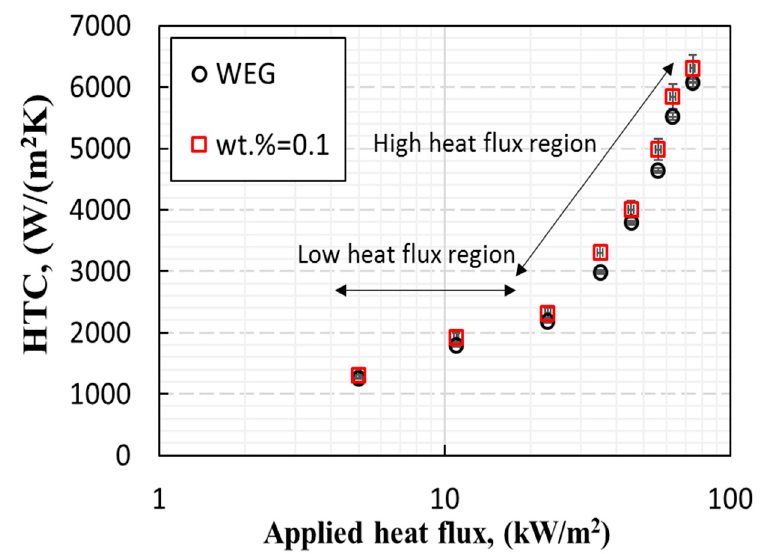
Figure 3. Variation of the heat-transfer coefficient (HTC) of the system with the uniform applied heat-flux for WEG and nanofluid at wt. % = 0.1.